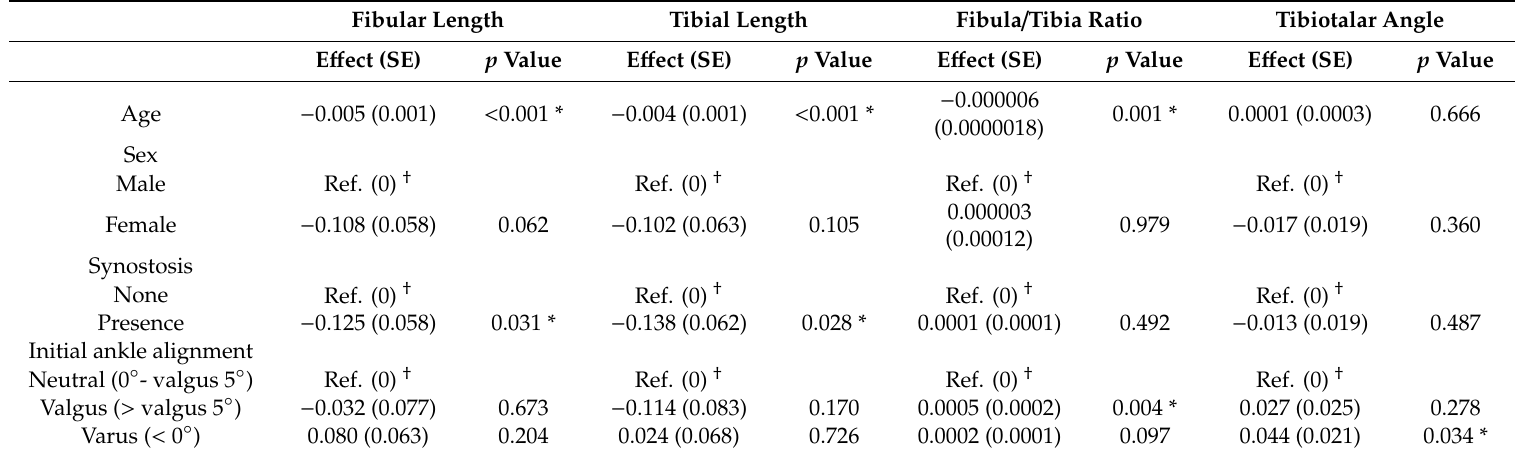
Table 4. Interactive e ff ects between the parameters at initial visit and the tibiofibular